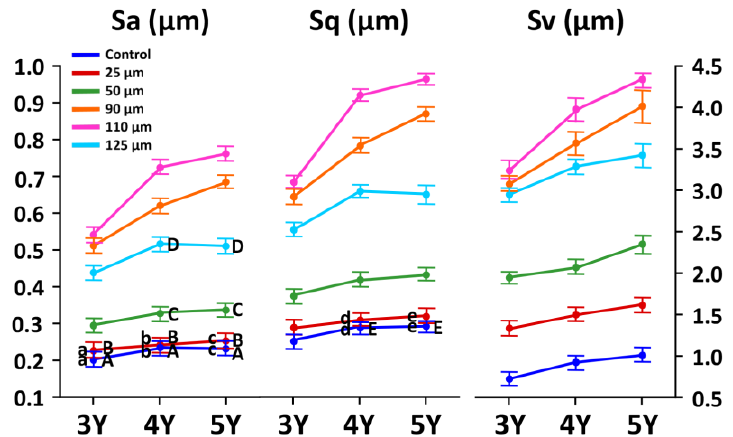
Figure 5. The surface texture parameters of each subgroup for three different zirconia grades. Mean values represented with same uppercase letters (within each row) or lowercase letters (within each column) are not significantly different based on the results of pairwire comparisons for simple main effects using Sidak adjustment ( p > 0.05). The values of the Sa, Sq, or Sv parameters increased with an increase in the particle size up to 110 µ m, whereas those values decreased with 125 µ m